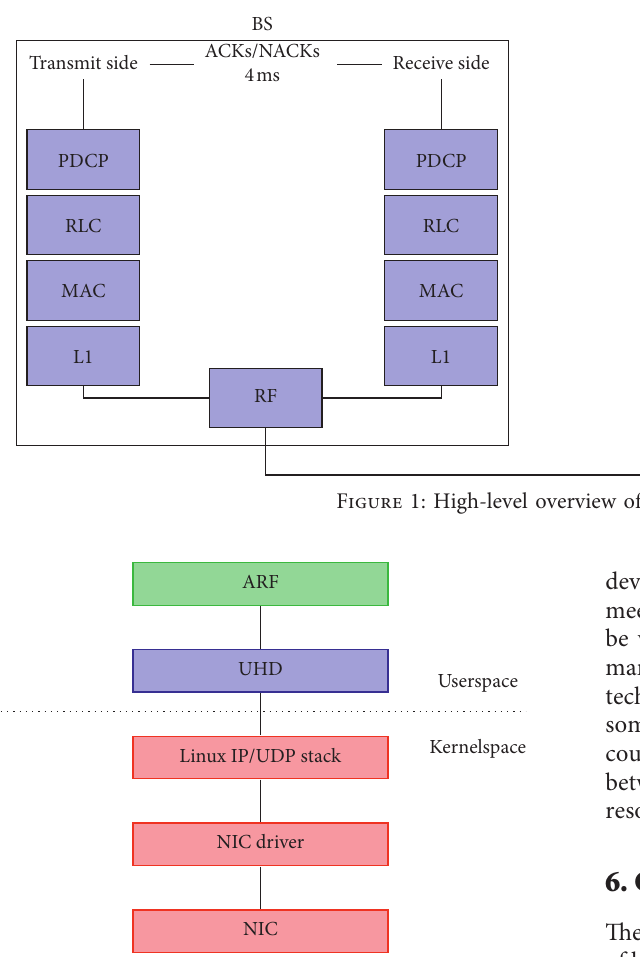
Figure 2: Overview of the main system components.